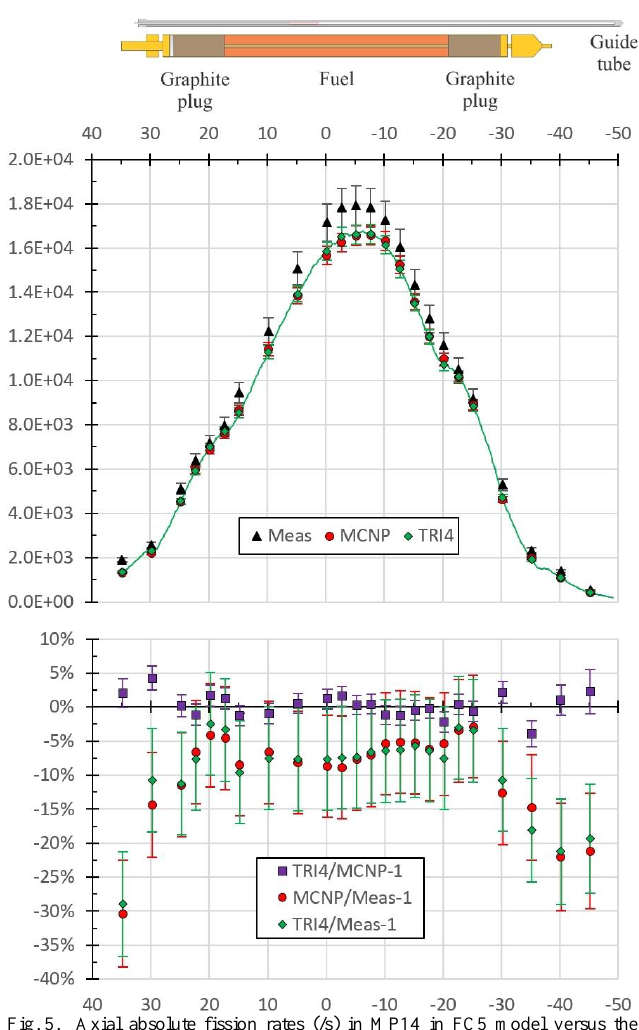
Fig. 5. Axial absolute fission rates (/s) in MP14 in FC5 model versus the altitude Z (cm) with a schematic of a standard fuel element at same altitudes. As MCNP model absolute fission rates and benchmark- model measurements are accessible in the NEA report, only TRIPOLI-4 absolute fission rates are presented in the present work: FC5 ones in Table I and FC8 in Table II for every MPs, except MP20, which is in Table III for both FC5 and FC8. “Val.” means the absolute fission rate and “σ Stat ” means only the statistical uncertainty (i.e. without ±2.6% for FC5 or ±2.7% for FC8 due to the combined uncertainty of the K factor and the nuclear